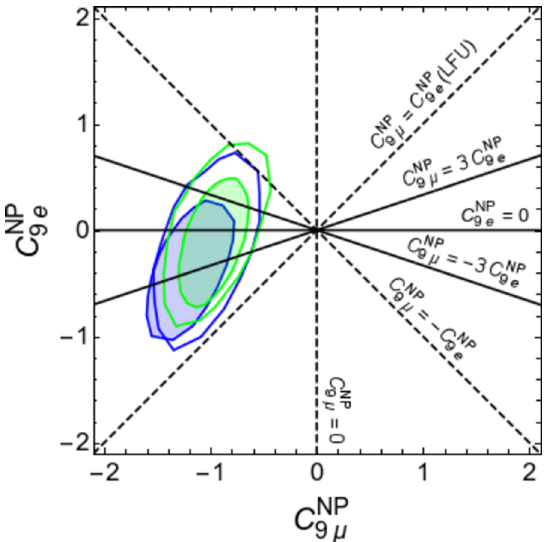
, C NP ) plane, preferred at 2 σ from global fits. The blue contours Figure 1 . The values in the ( C NP 9 µ 9 e correspond to the fits in [20, 22], and the green contours to the fits in [21, 23]. The filled contours correspond to the fits based on the updates in Moriond 2021 [20, 21], while the unfilled ones correspond to the older results based on data available after Moriond 2019 [22, 23]. The black solid and dashed lines correspond to fixed ratios of C NP and C NP . The ratios corresponding to the 9 e 9 µ dashed lines are disfavoured from the b → s global